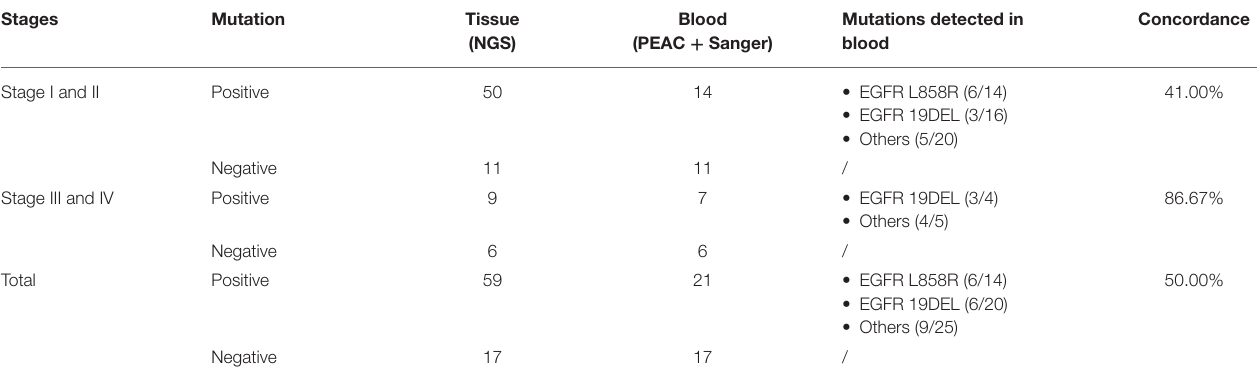
TABLE 2 | The concordance rate of PEAC system on paired tissue and plasma samples from 76 NSCLC patients. Stages Mutation Tissue